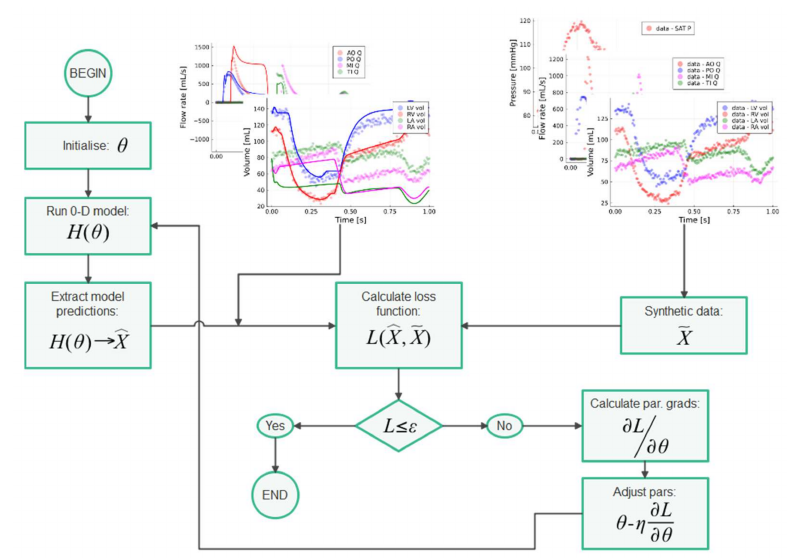
Figure 1. Computer model